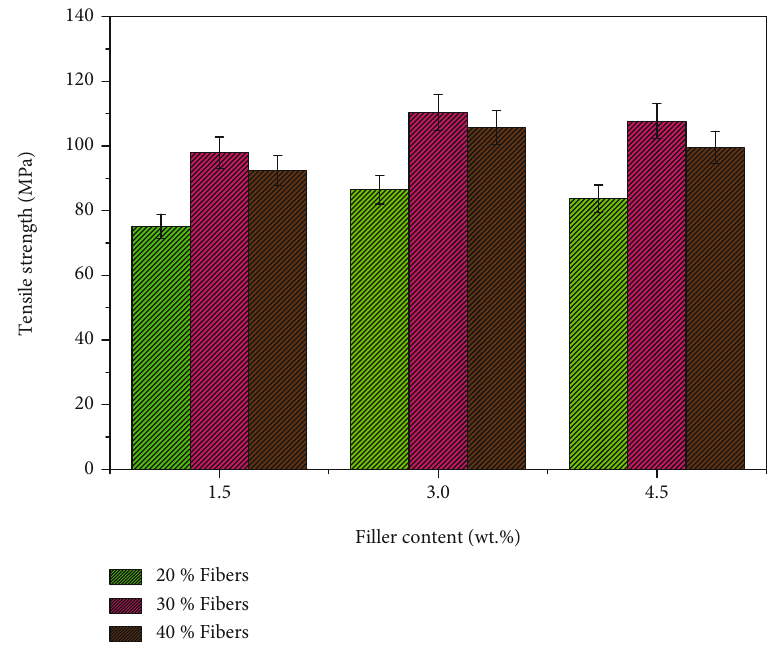
Figure 4: Tensile strength of nanocomposites with di ff erent fi ller and fi bre content.